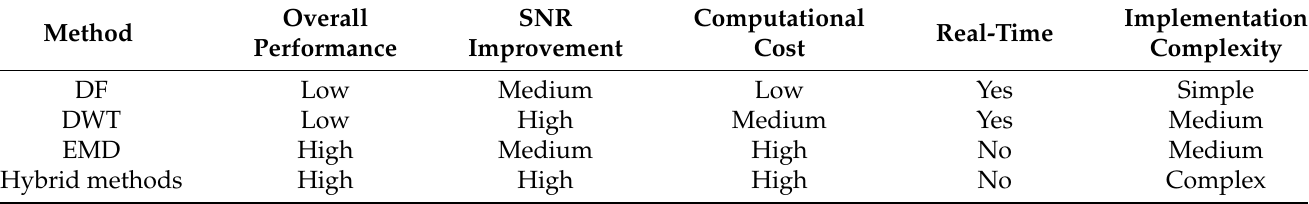
Table 6. Summary of the EHG signal processing